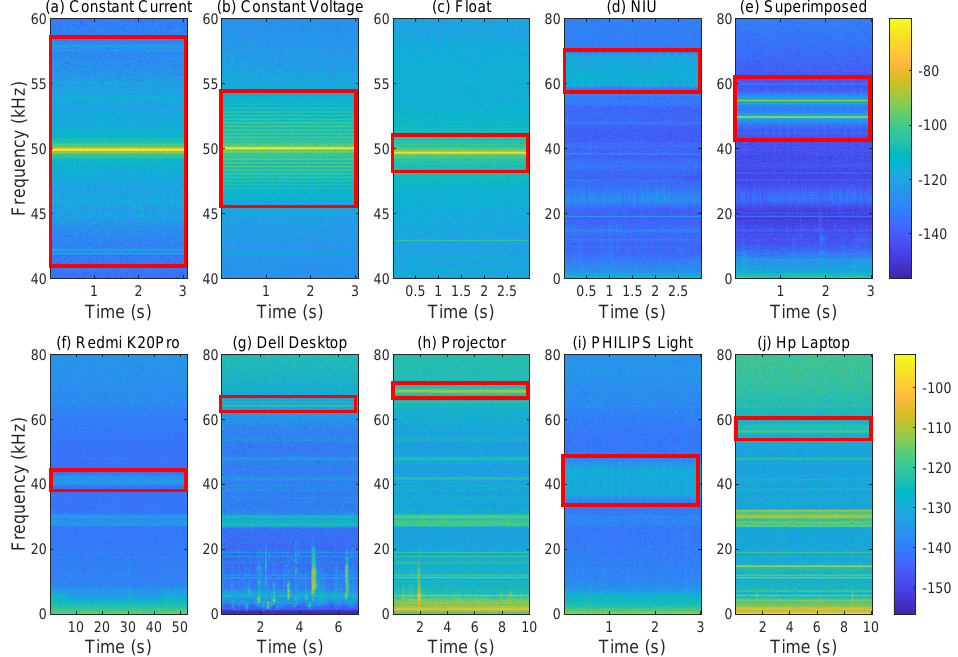
Figure 4. PFC signals generated by different e-bikes and appliances. ( a – c ) are generated by the XDAO (160 W) e-bike during different charging stages. ( d ) is generated by the NIU (160 W) e-bike during the constant current stage. ( e ) is the superimposed signal generated when YADEA (180 W) and XDAO work simultaneously. ( d – f ) are PFC signals generated by Redmi K20Pro (27 W), Dell desktop (360 W), Projector (225 W), PHILIPS Light (18 W), and Hp Laptop (90 W),